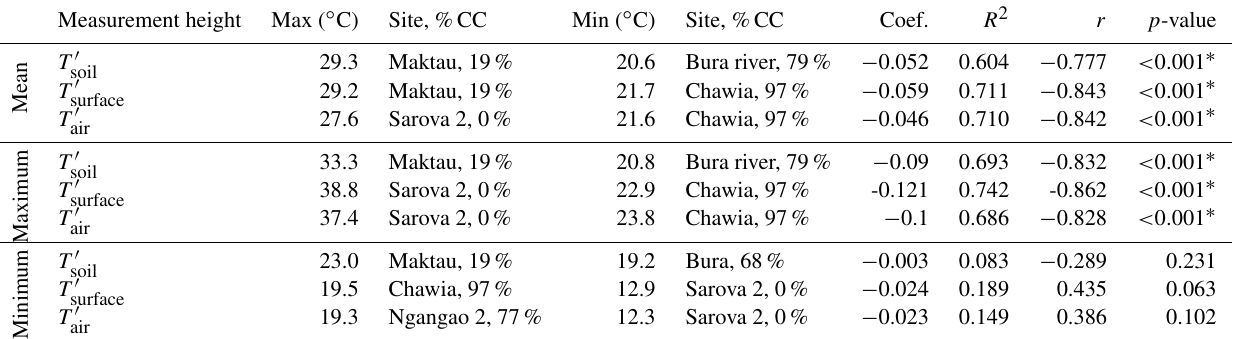
Table 3. Topographically corrected temperature ( T (cid:48) ) statistics for the soil, surface, and air. Temperatures in the maximum and minimum columns refer to the highest and lowest mean, maximum, and minimum temperatures. Site refers to where the highest and lowest temperatures were measured and their respective canopy cover (CC) percentage. ∗ Indicates statistical